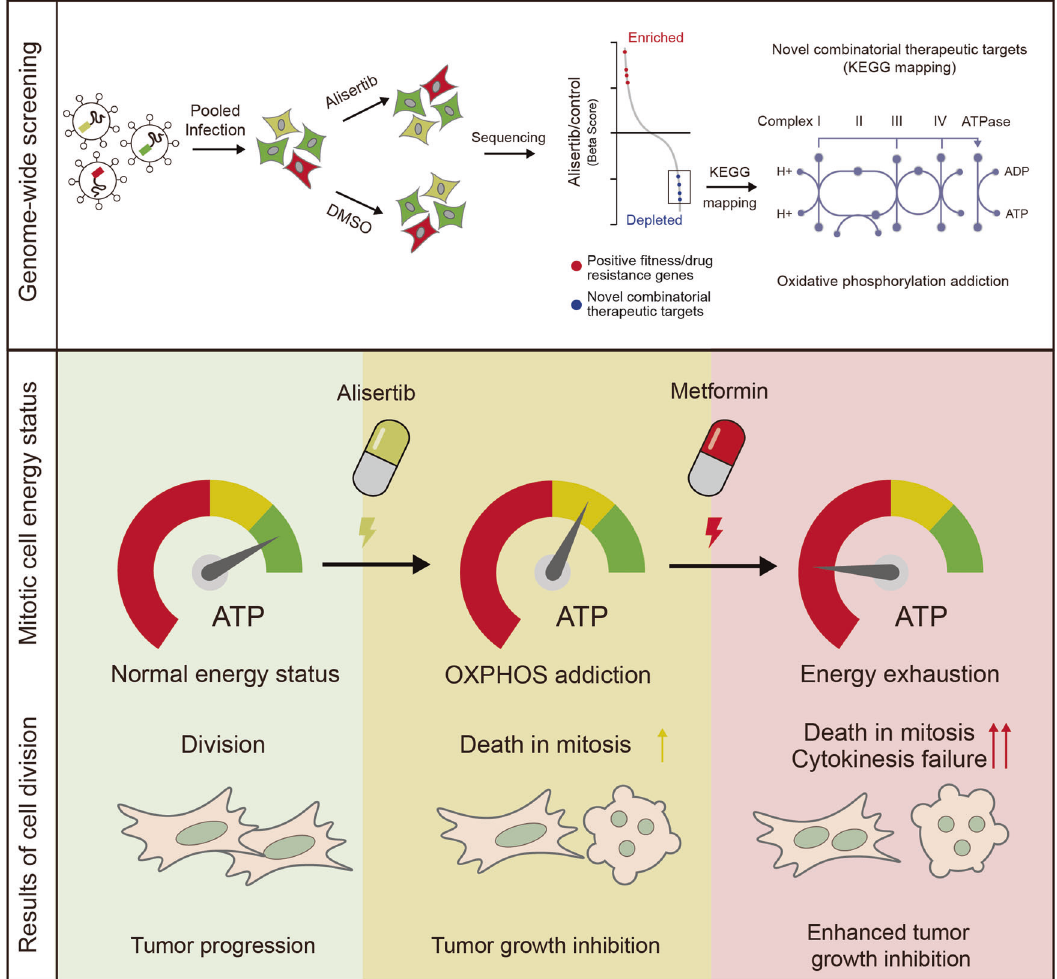
Fig. 7 Graphic illustration of the synthetic lethal interaction between mitotic kinase inhibition and OXPHOS inhibition. Upper panel: Genome-wide knockout screening and KEGG pathway mapping of synthetic lethal targets of alisertib. Lower panel: Alisertib treatment reduces ATP concentrations in mitotic cells and OXPHOS inhibitors enhance the antineoplastic activity of alisertib through joint strike on energy homeostasis in mitotic cells. OXPHOS inhibitor treatment further reduces the intracellular ATP concentration in alisertib-treated mitotic cells, increasing the frequency of death in mitosis and cytokinesis